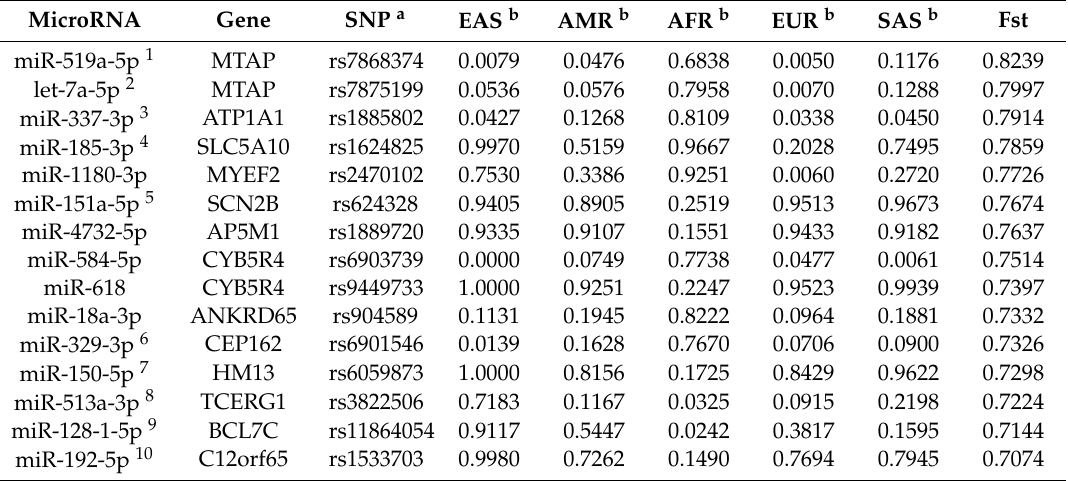
Table 1. MicroRNA target sites, not in the reference genome sequence, with a very high differentiation among human populations.